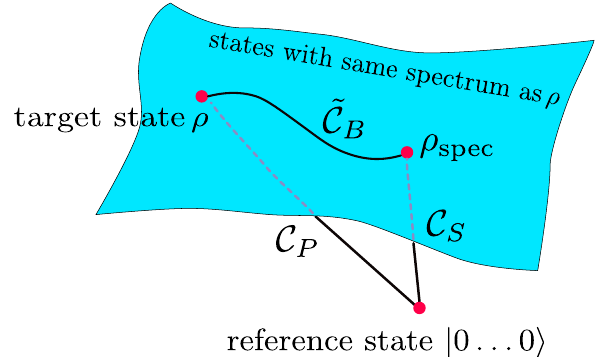
Fig. 8 Illustration of spectrum and basis complexity for mixed states